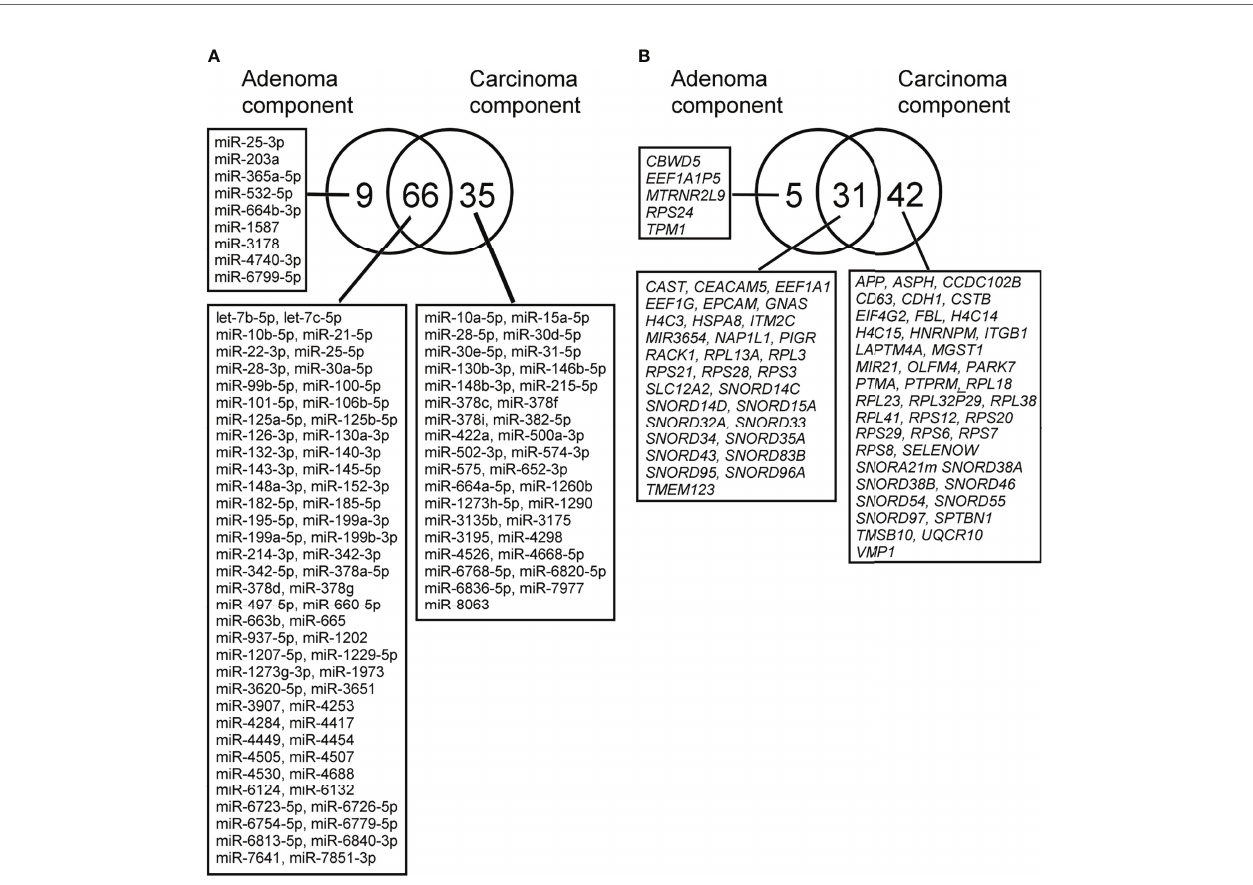
FIGURE 4 | (A) . Differential expression of miRNAs between isolated adenoma and carcinomatous glands samples obtained from “ cancer in/with adenoma ” case, as depicted by Venn diagram analysis. The numbers of miRNAs identi fi ed in adenoma, and cancer glands were 9 and 35, respectively. Among the two lesions, a considerable number of miRNAs overlapped with each other (adenoma and cancer, 31 miRNAs). 2-B . Differential expression of mRNAs between isolated adenoma and carcinomatous glands samples obtained from “ cancer in/with adenoma ” case, as depicted by Venn diagram analysis. The numbers of mRNAs identi fi ed in adenoma and cancer samples were 5, 31, and 42. Among the two lesions, a considerable number of mRNAs were overlapped (adenoma and cancer samples, 31 mRNAs).